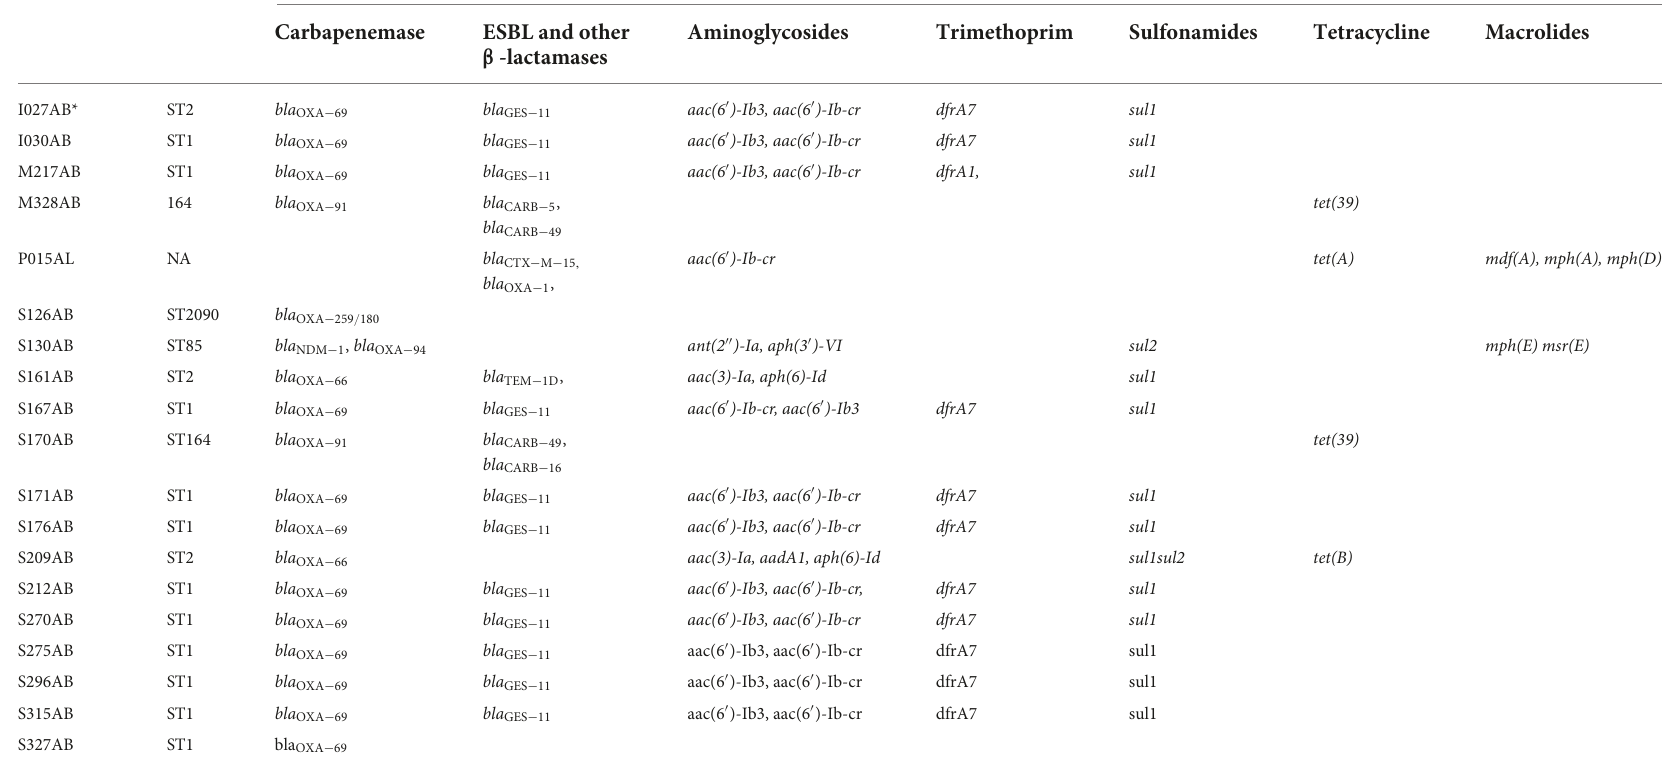
TABLE 3A Sequence types and resistance genes observed among carbapenem-resistant Acinetobacter species isolated at Jimma Medical Center, Ethiopia ( n = 19). Isolate